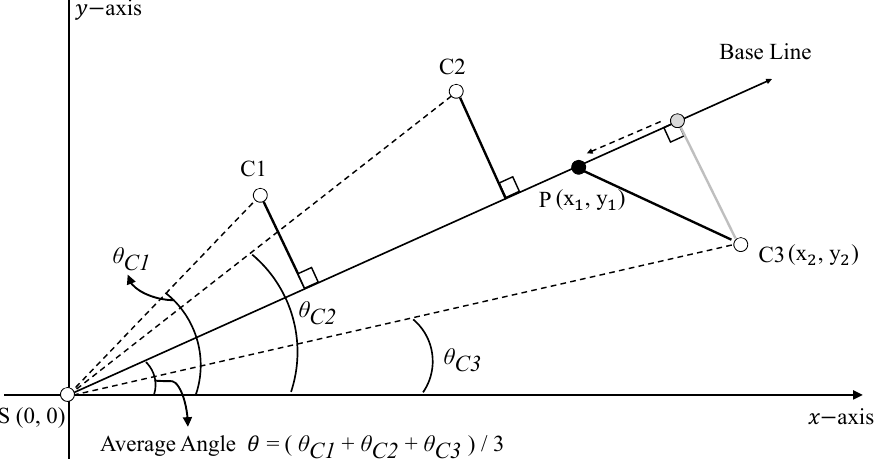
Figure 6. An example of multicasting tree